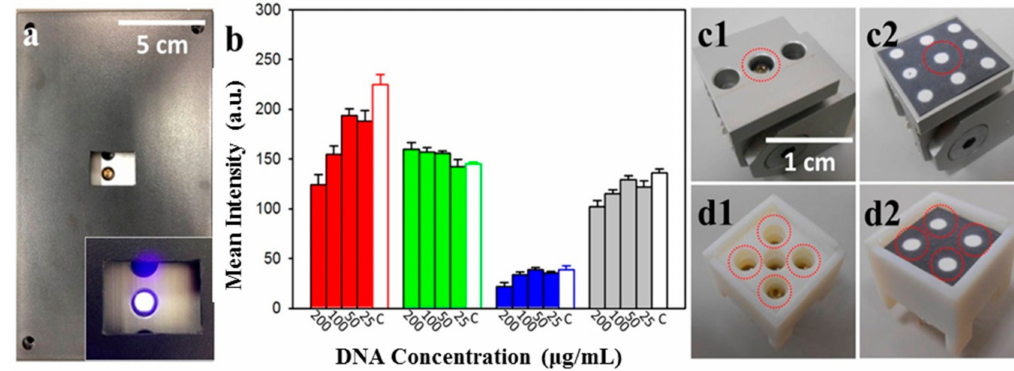
Figure 4. ( a ) The full top view of our device in operation. The hole of the lip is for image-taking with a cellphone lens, and the small insert image represents the light when switched on. ( b ) The intensity analysis of each RGB (i.e., Red, Green and Blue) channel and greyscale for different nucleic acid concentrations. The red channel intensity significantly increased when DNA concentration decreased (N = 8; mean ± standard deviation). The letter C means control group where the concentration is 0 µ g/mL. (c and d) Two types of UV-LED modules were designed for single-spot ( c1 and c2 ) and multi-spot detection ( d1 and d2 ). The dashed circles mark the UV-LED